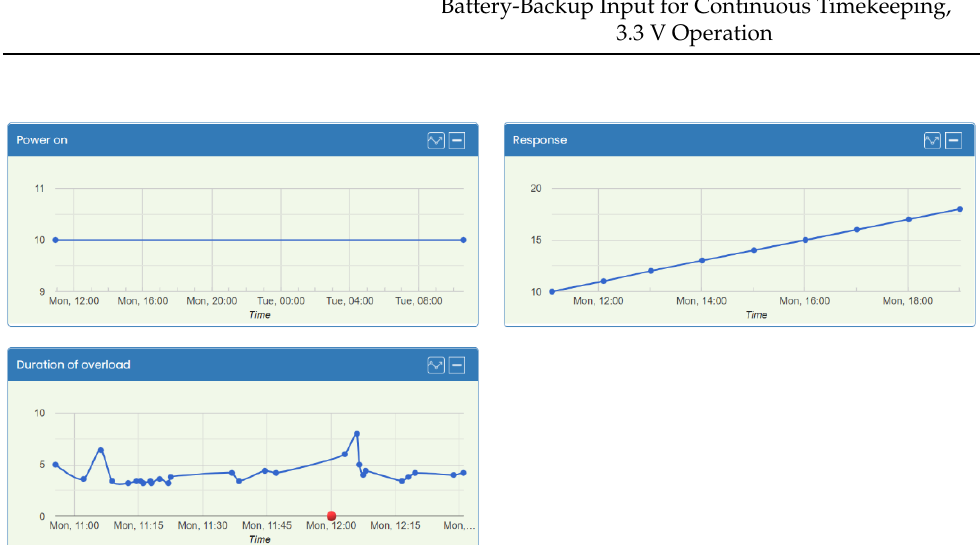
Figure 8. Data visualization within UoM IoT platform cloud service.